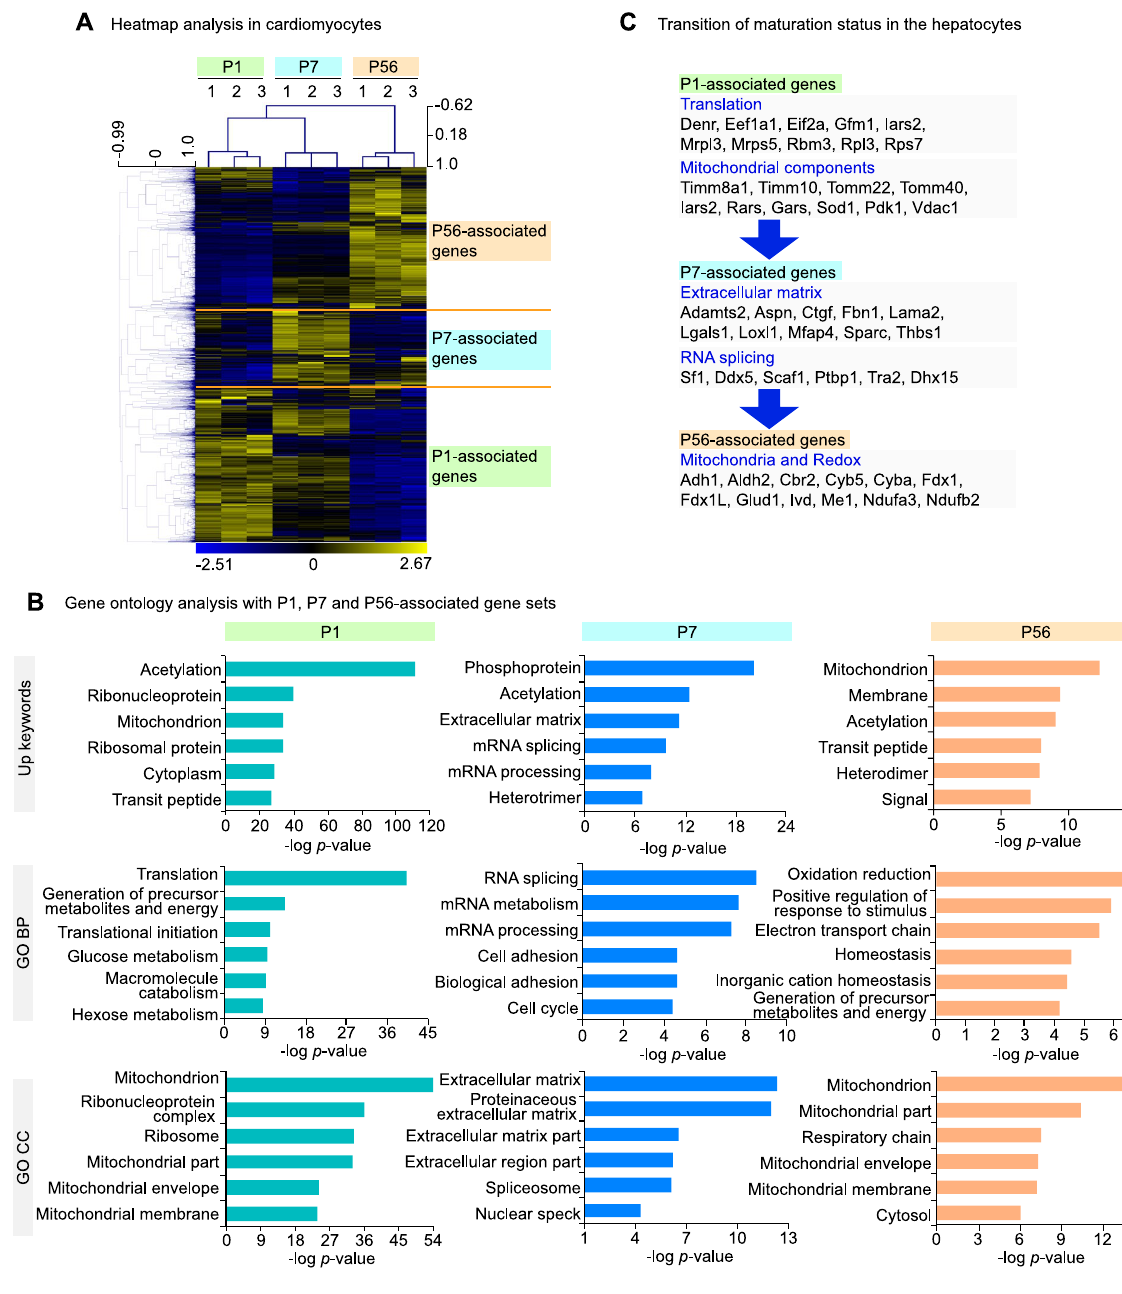
Figure 5. Maturation dynamics in the cardiomyocytes. ( A ) Heatmap analysis of transcriptome analysis in the cardiomyocytes at different ages. The distinct sets of genes were present as noted as P1-, P7- and P56- associated genes. ( B ) The GO analysis describing the transition of cellular functions in the cardiomyocytes. ( C ) A schematic for the transition of the cellular functions in the postnatal